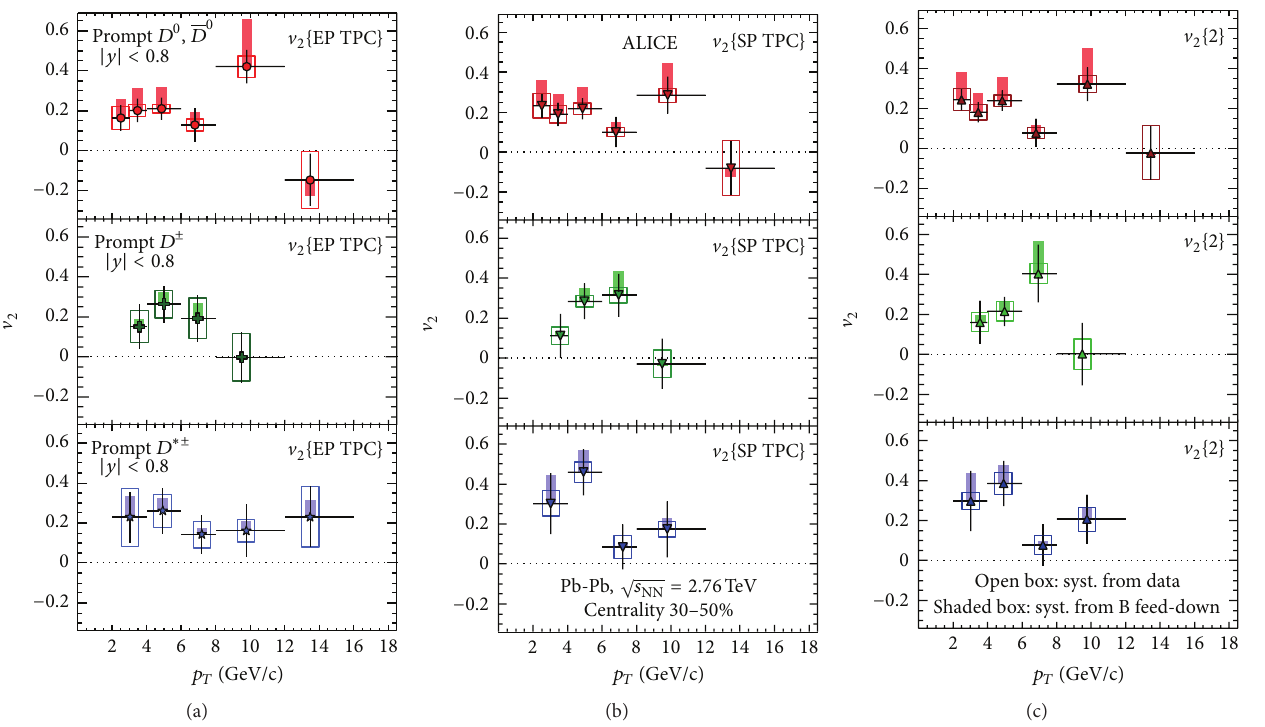
Figure 4: Elliptic flow as a function of 𝑝 𝑇 in the 30–50% centrality bin, for 𝐷 0 , 𝐷 + , and 𝐷 ∗+ mesons with the event plane, scalar product, and two-particle cumulant methods [30]. The vertical error bars represent the statistical uncertainty; the open boxes are the systematic